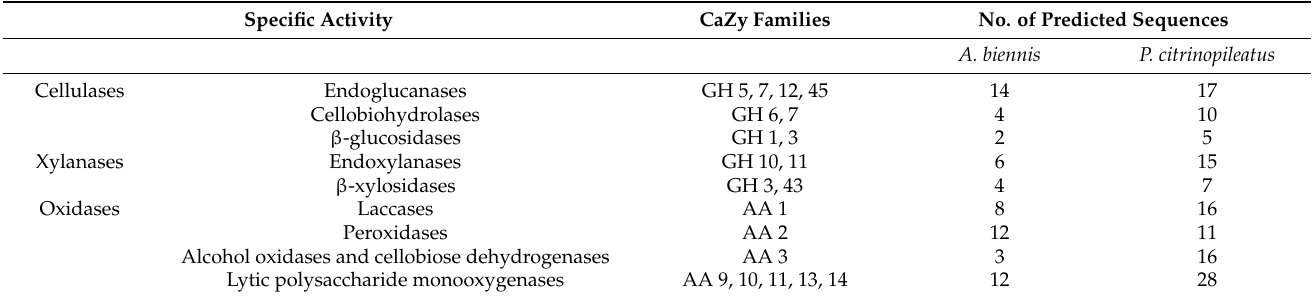
Table 1. Predicted protein sequences present in the A. biennis and P. citrinopileatus genome, relative to lignocellulose degradation. Specific